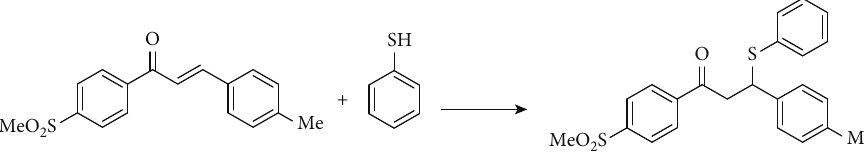
Figure 1: The reaction of the synthesis of 1-(4-(methylsulfonyl)phenyl)-3-(phenylthio)-3-(p-tolyl)propan-1-one (MPP). Table 1: Speci fi c primers used in real-time PCR analysis.